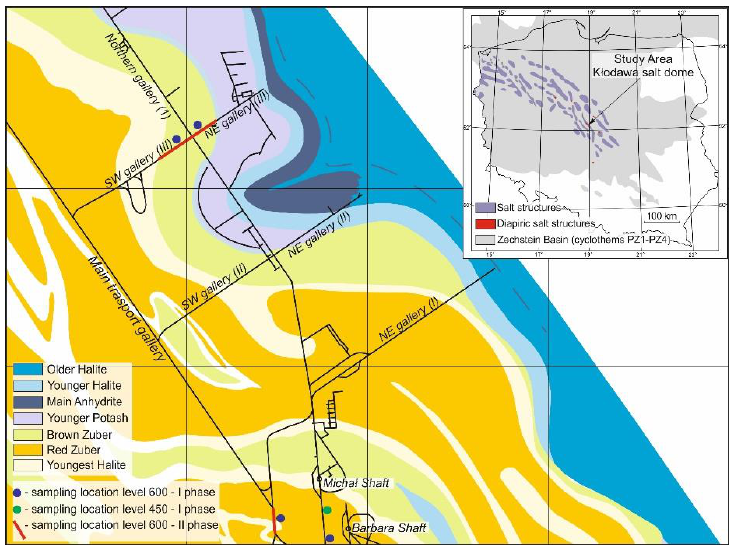
Figure 1. Study area and sampling locations in the Kłodawa Salt Mine on the background of the local geological structure (according to [33,41]).